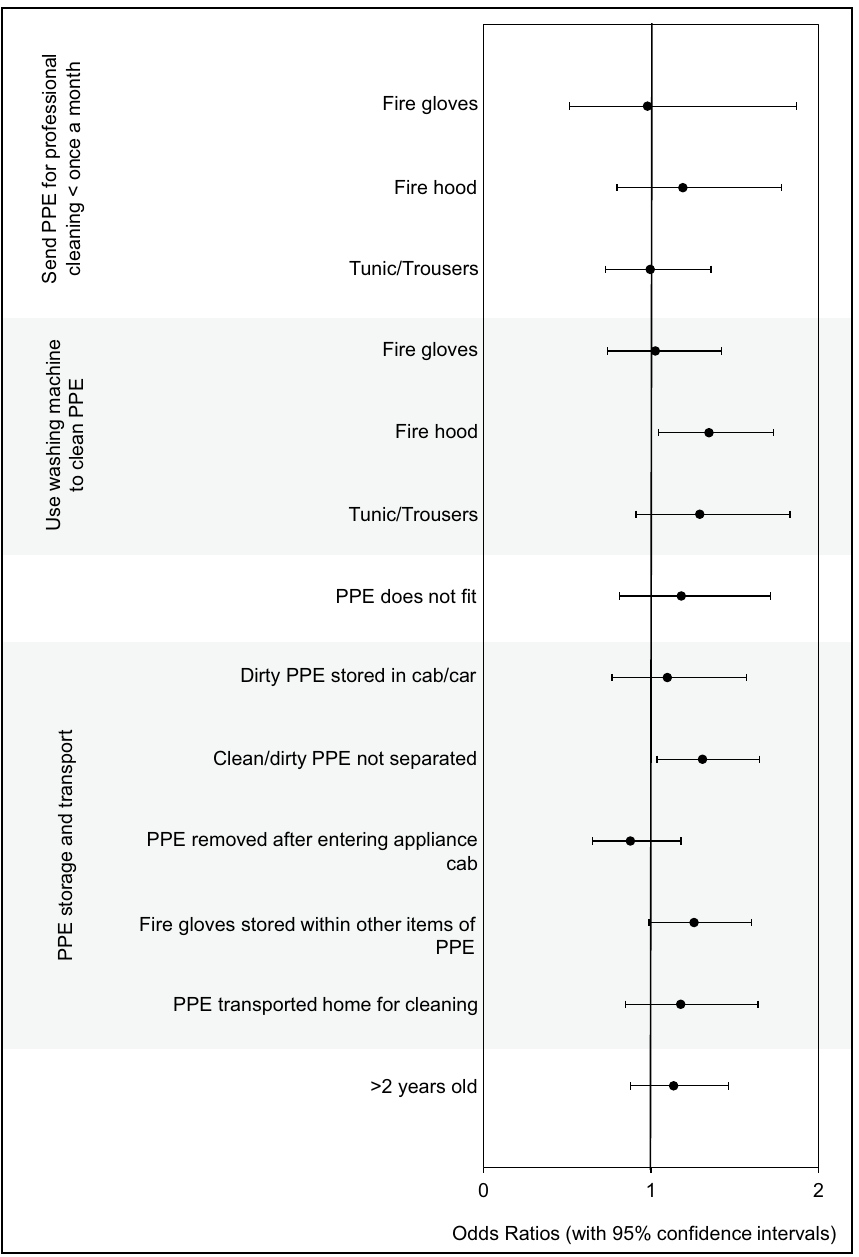
Figure 5. PPE contamination and cancer odds ratios for UK firefighters. Odds ratios (with 95% confidence intervals) were adjusted for